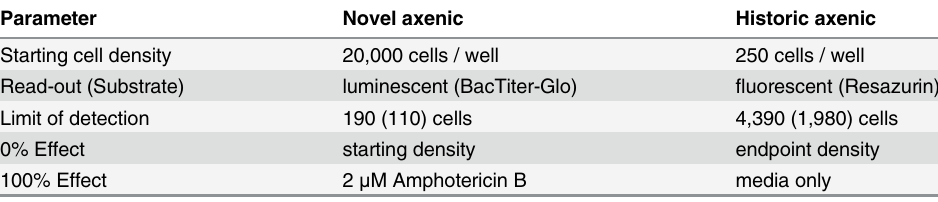
Table 1. Comparison of the novel versus the historic axenic Leishmania donovani